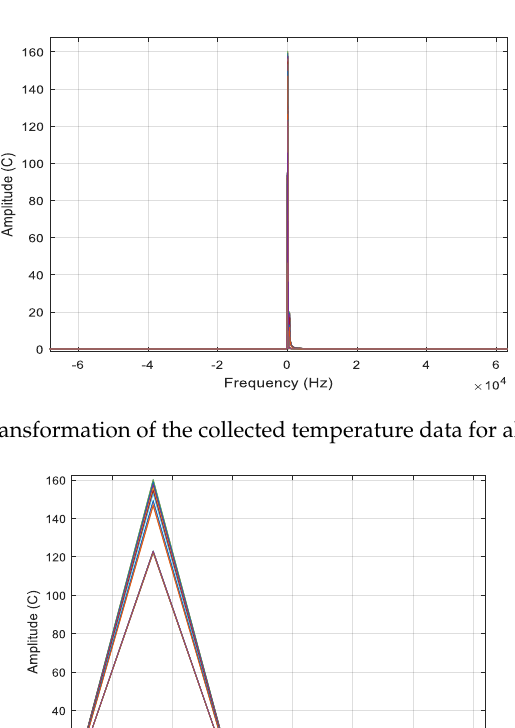
Figure 11. Sensor temperature for machine with 10% eccentricity faults.